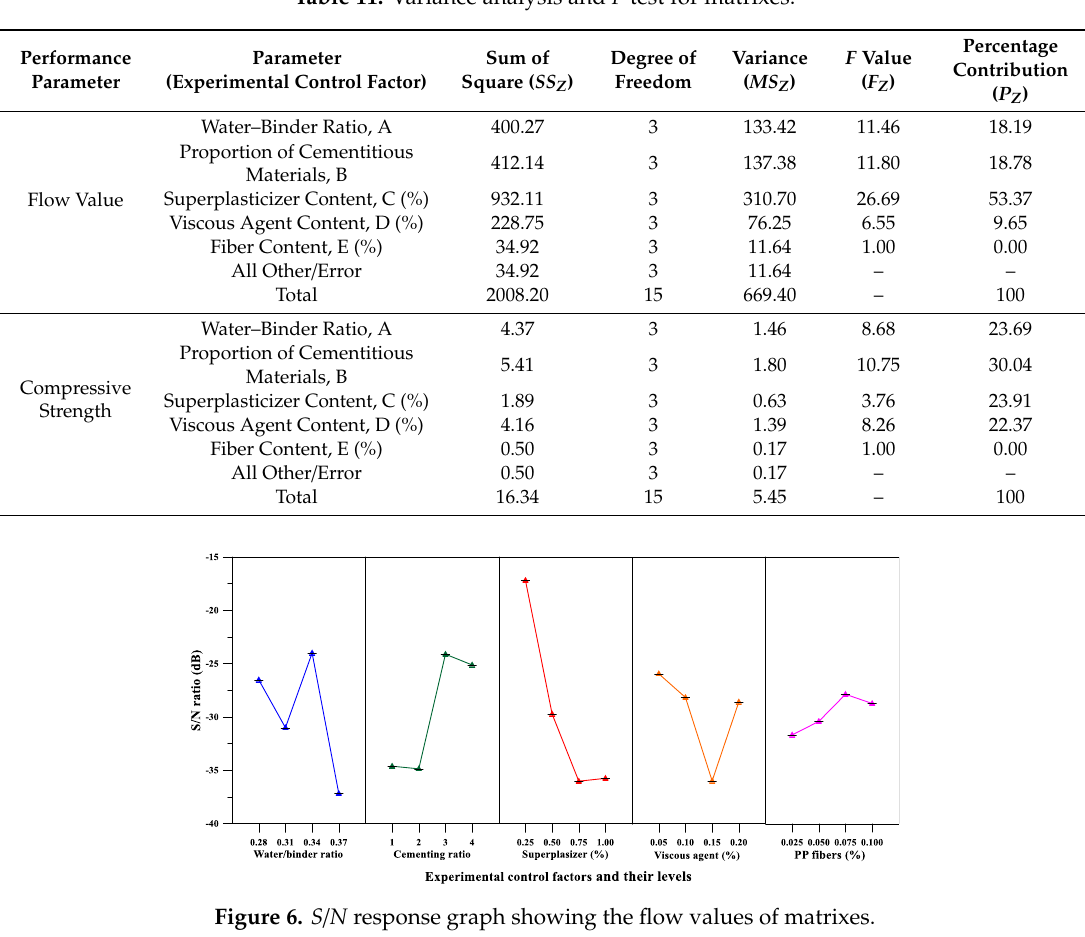
Figure 6. S / N response graph showing the flow values of matrixes.